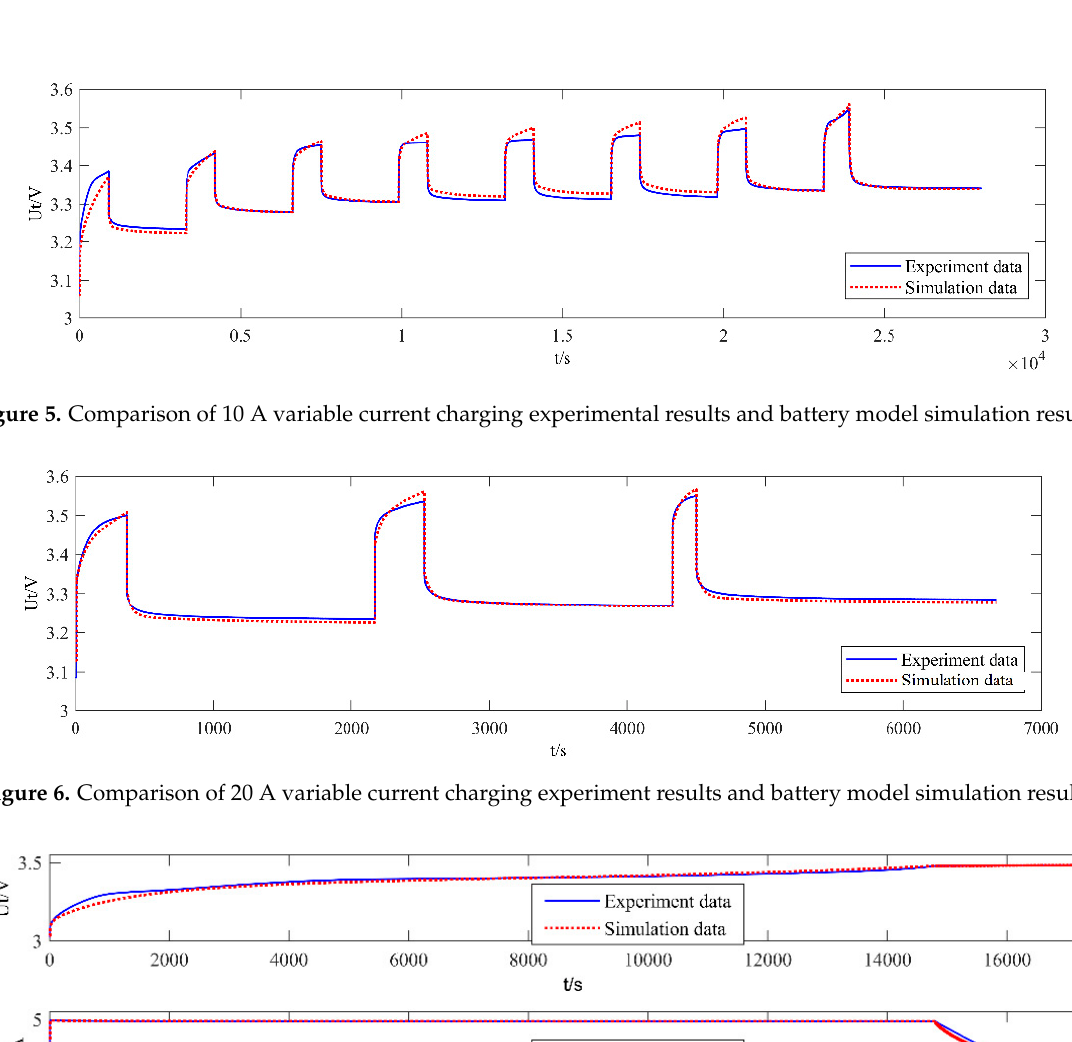
Figure 4. Comparison of 5 A variable current charging experiment results and battery model simulation results.